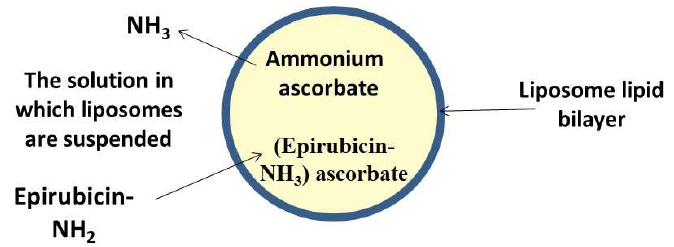
Figure 4. Schematic representation of epirubicin encapsulation within liposomes via indirect encapsulation—ammonium ascorbate gradient.